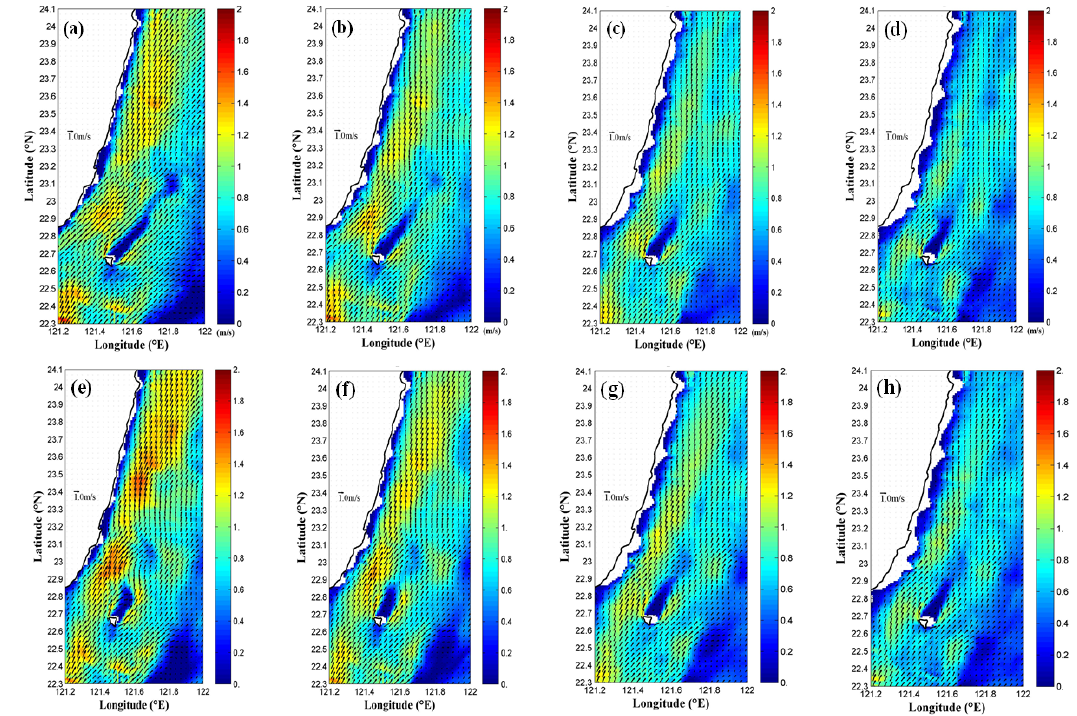
Figure 15. The velocity fields at water depths of ( a , e ) 20, ( b , f ) 50, ( c , g ) 100, and ( d , h ) 150 m of the numerical results obtained by ( a – d ) real SW and ( e – h ) no wind conditions.